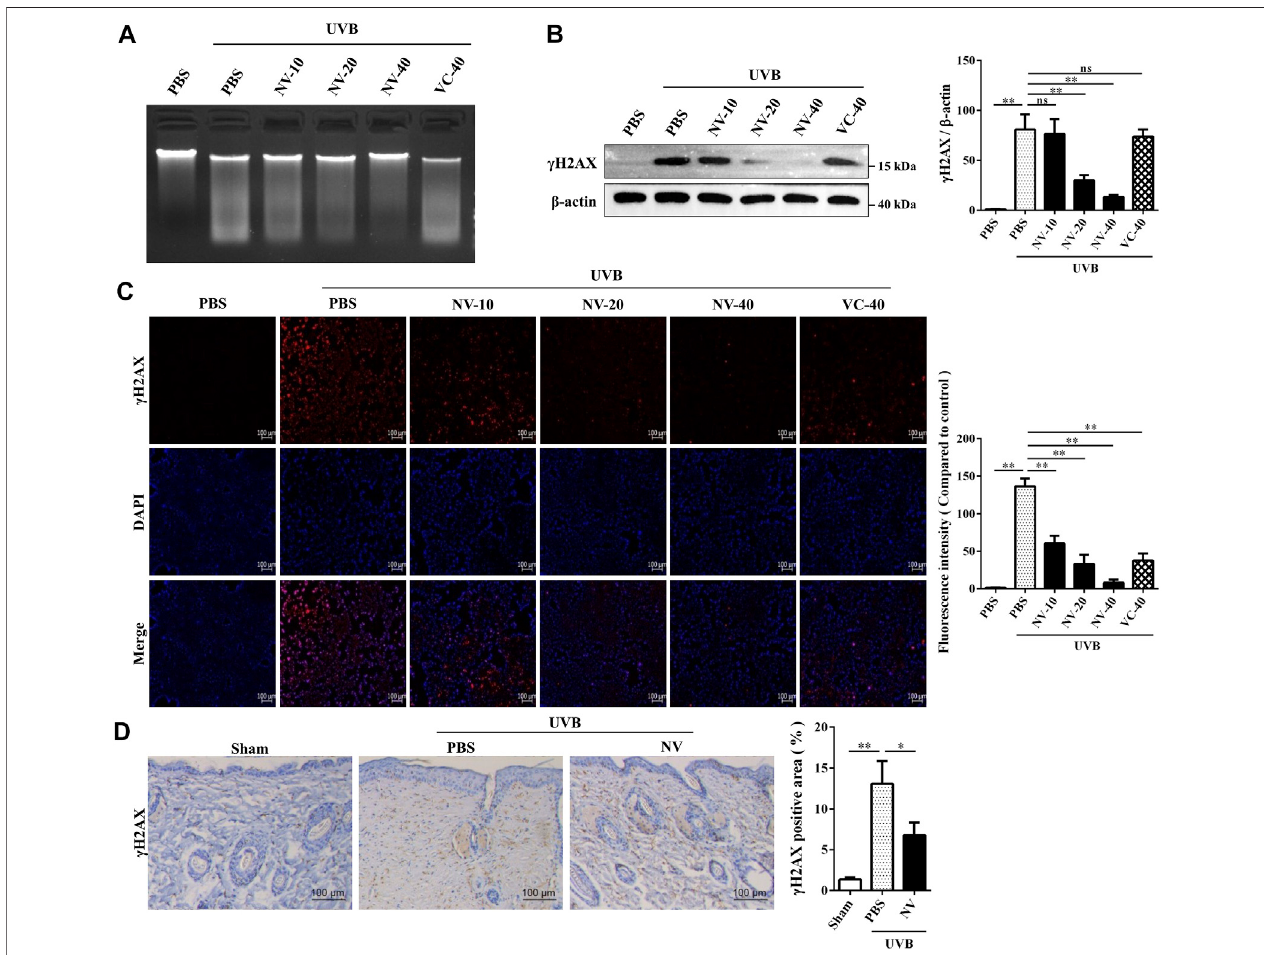
FIGURE 4 | Antioxidin-NV inhibited UVB-induced DNA damage in vivo and in vitro . (A) HaCaT cells were treated with samples for 24 h after UVB irradiation and HaCaT cells DNA were extracted for DNA fragmentation analysis. (B) : Western blot was performed to analyze the expression of γ H2AX proteins in HaCaT cells. relative activation analysis were quanti fi ed by Image J. (C) The expression of γ H2AX in HaCaT cells was analyzed by cell immuno fl uorescence analysis. γ H2AX proteins are stained red. Scale bar (cid:1) 100 μ m. (D) Immunohistochemical staining of skin tissues was used to determine the expression levels of γ H2AX in HaCaT cells. γ H2AX proteinsarestainedbrown(Indicatedbyredarrow).Scalebar (cid:1) 100 μ m.Dataarepresentedasmean ± SD( n (cid:1) 3).NV-10,20,40,VC-40indicatedtheconcentrationsof 10, 20, 40 μ g/ml respectively. ns, no signi fi cance, * p < 0.05, ** p <